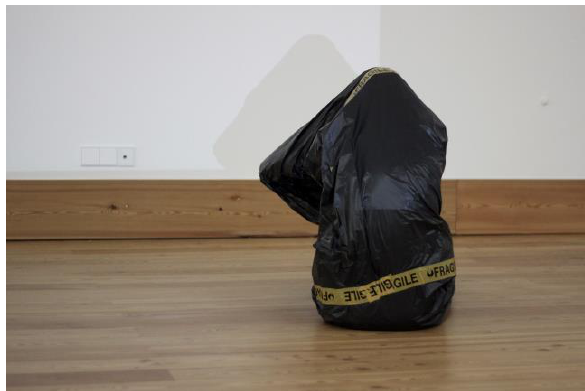
Figure 1 | Photo by José